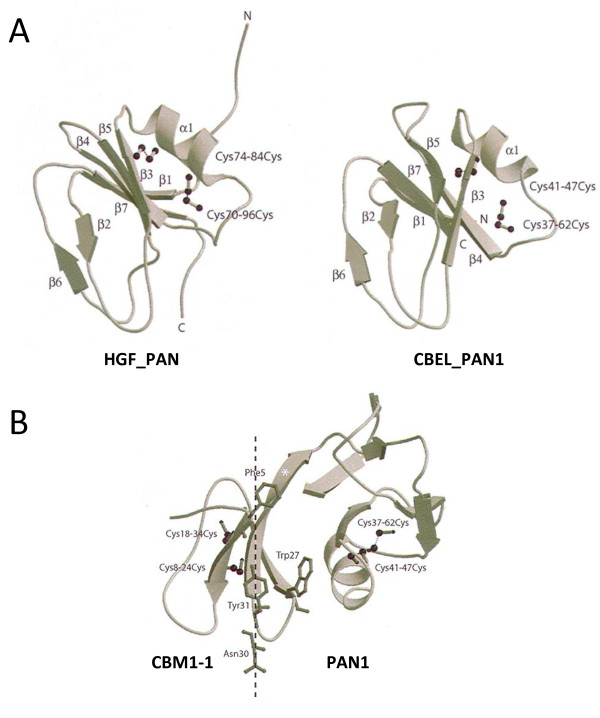
Stereo ribbon representation of PAN and CBM1-PAN1 from CBEL bound to cellulose.A) Comparison of the ribbon diagrams of domains HGF_PAN (left) and CBEL_PAN1-1 (right). The α-helix (α1) and strands of b-sheets (β1-β2) are numbered from the N- to the C- terminus. The cysteine residues linked by disulphide bonds (dashed lines) are displayed in black ball-and-sticks and numbered. B) The cysteine residues linked by disulphide bonds (dashed lines) are displayed in black ball-and-sticks and numbered. The extended strand of β-sheet interconnecting the two domains is indicated by an asterisk. The aromatic residues of CBM1 interacting with cellulose are in grey ball-and-sticks and labelled. The figures are drawn using Molscript
[67], and Raster3D
[68].